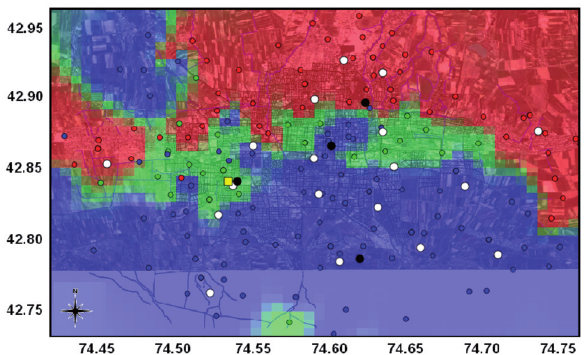
Figure 2. Temporary network (white dots) installed in Bishkek in summer 2008, array measurement sites (black dots) and location of the vertical array (yellow rectangle). The color-coded dots repre- sent the location of the single station seismic noise measurement sites. Different colors represent the different clusters or groups.